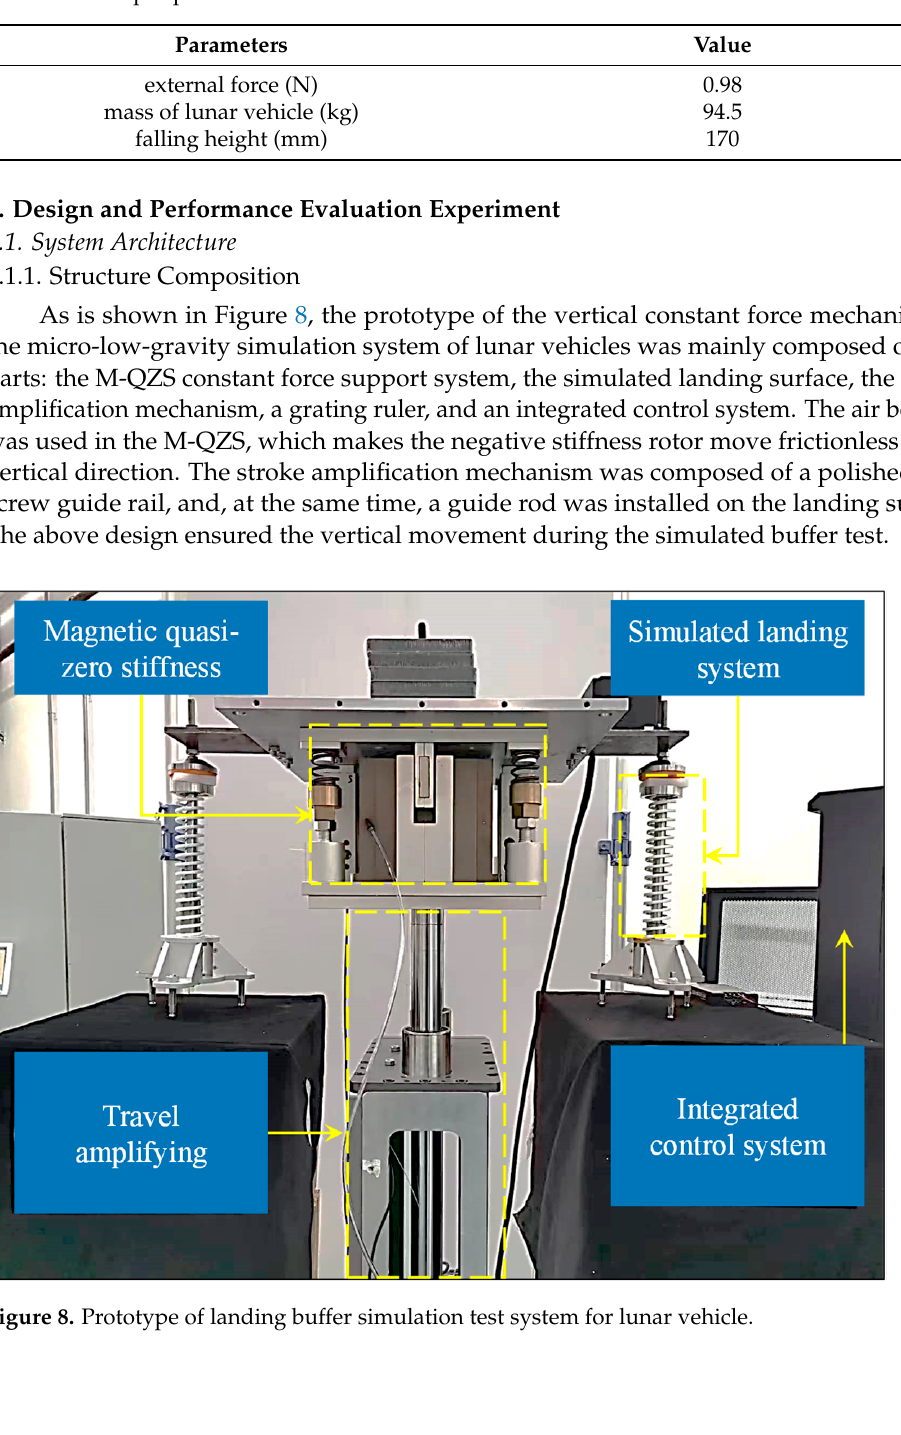
Table 1. The input parameters for simulation test.